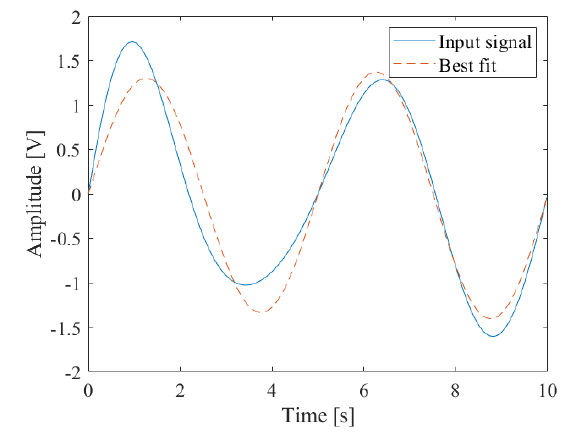
Figure 20. First 10 s time window of the acquired signal and its estimated best fit.